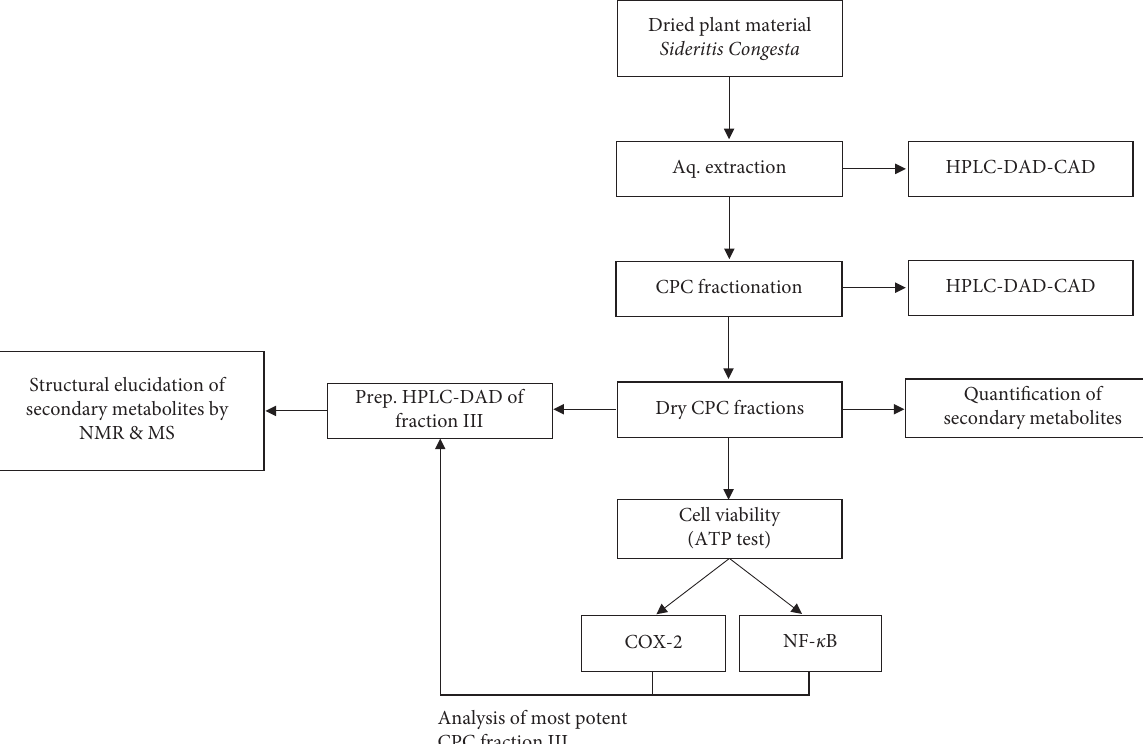
Figure 2: Schematic diagram of the performed process in this study.